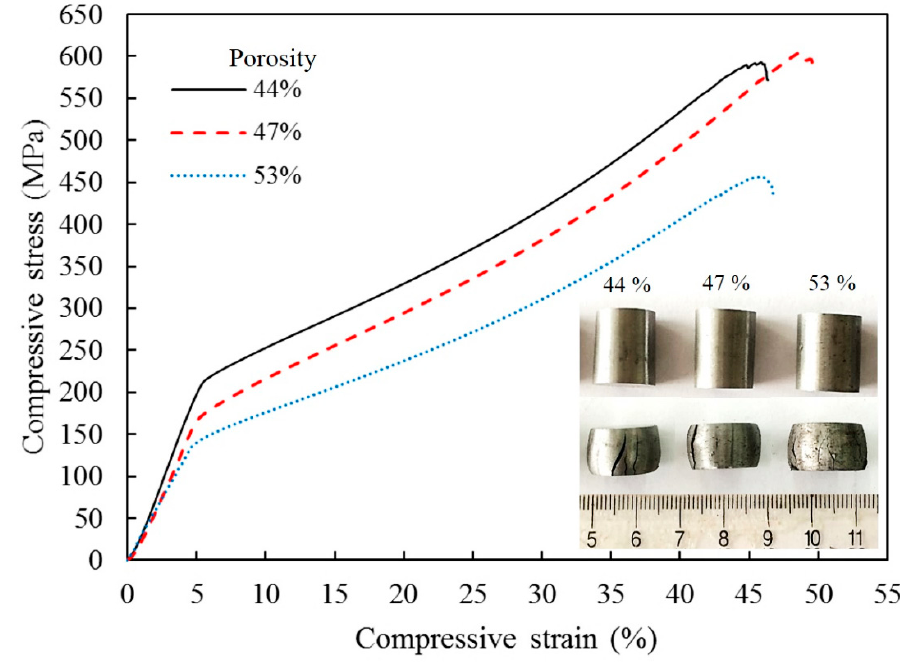
Figure 3. Room temperature uniaxial compressive stress–strain curves of porous iron prepared by pressureless SPS.